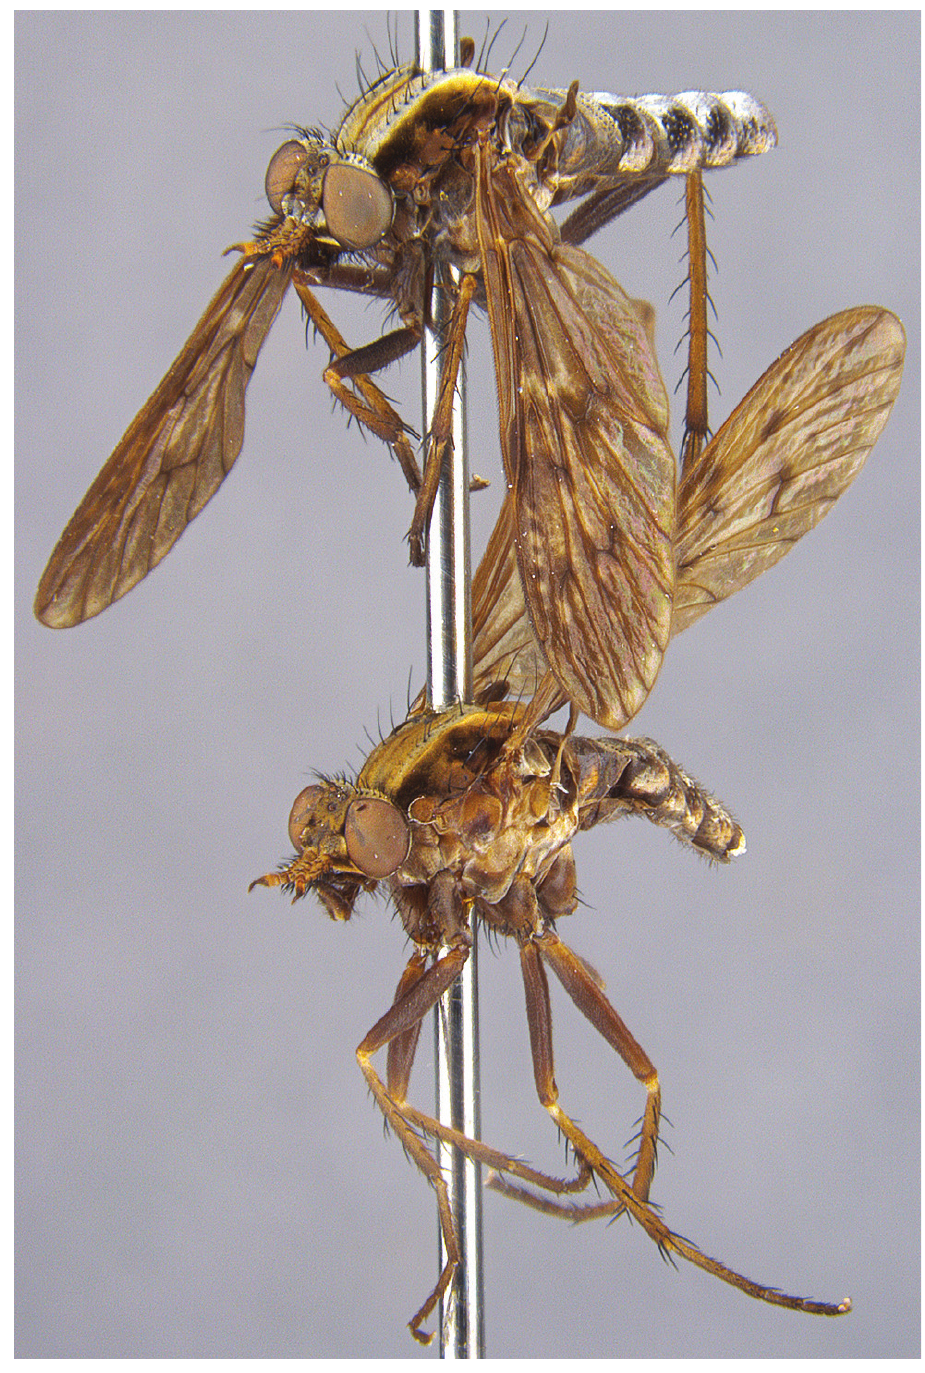
Figure 17. Sidarena yallingup sp. n.: Male (upper) and female (lower), oblique view (terminalia